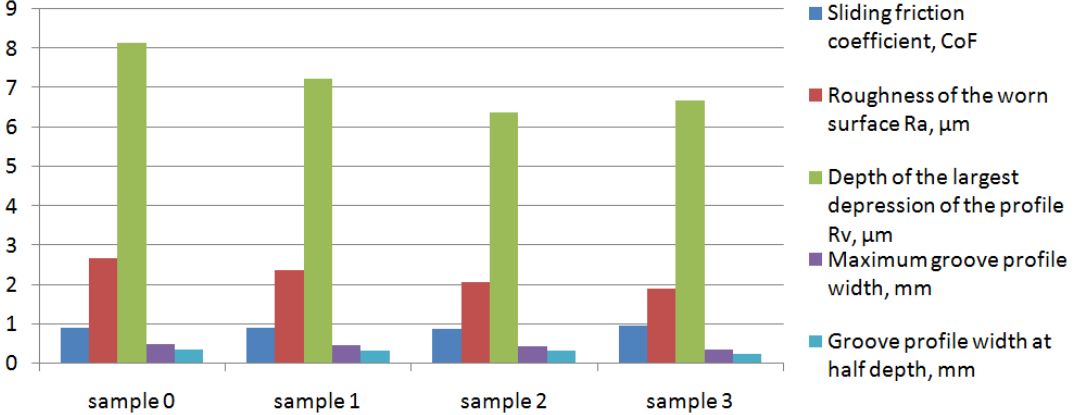
Figure 9. Values of sliding friction coefficient, surface roughness, and dimensions of grooves on the surface of low-chromium cast iron samples after dry friction